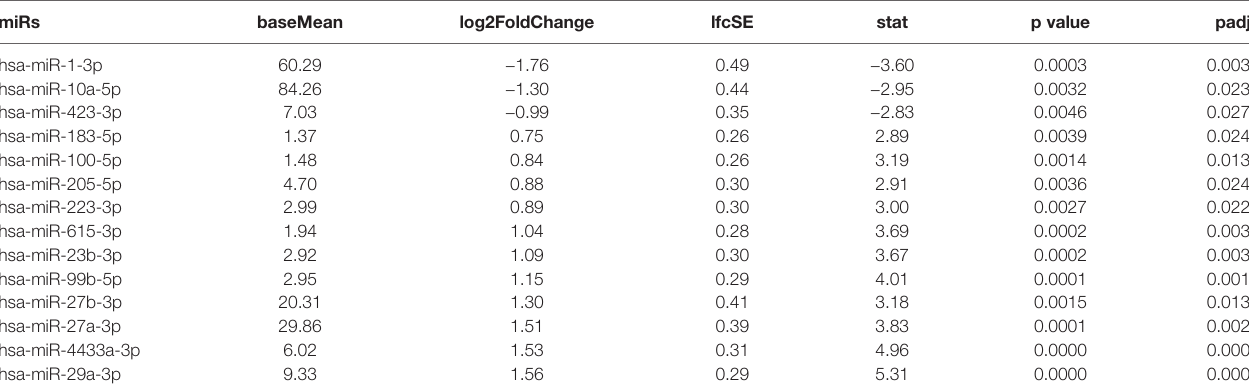
TABLE 2 | Table of differentially expressed miRNA comparing Gleason score ≥ 8 to the Gleason score ≤ 7 and Bx-negatives adjusted for batch effect. miRs baseMean log2FoldChange lfcSE stat p value padj hsa-miR-1-3p